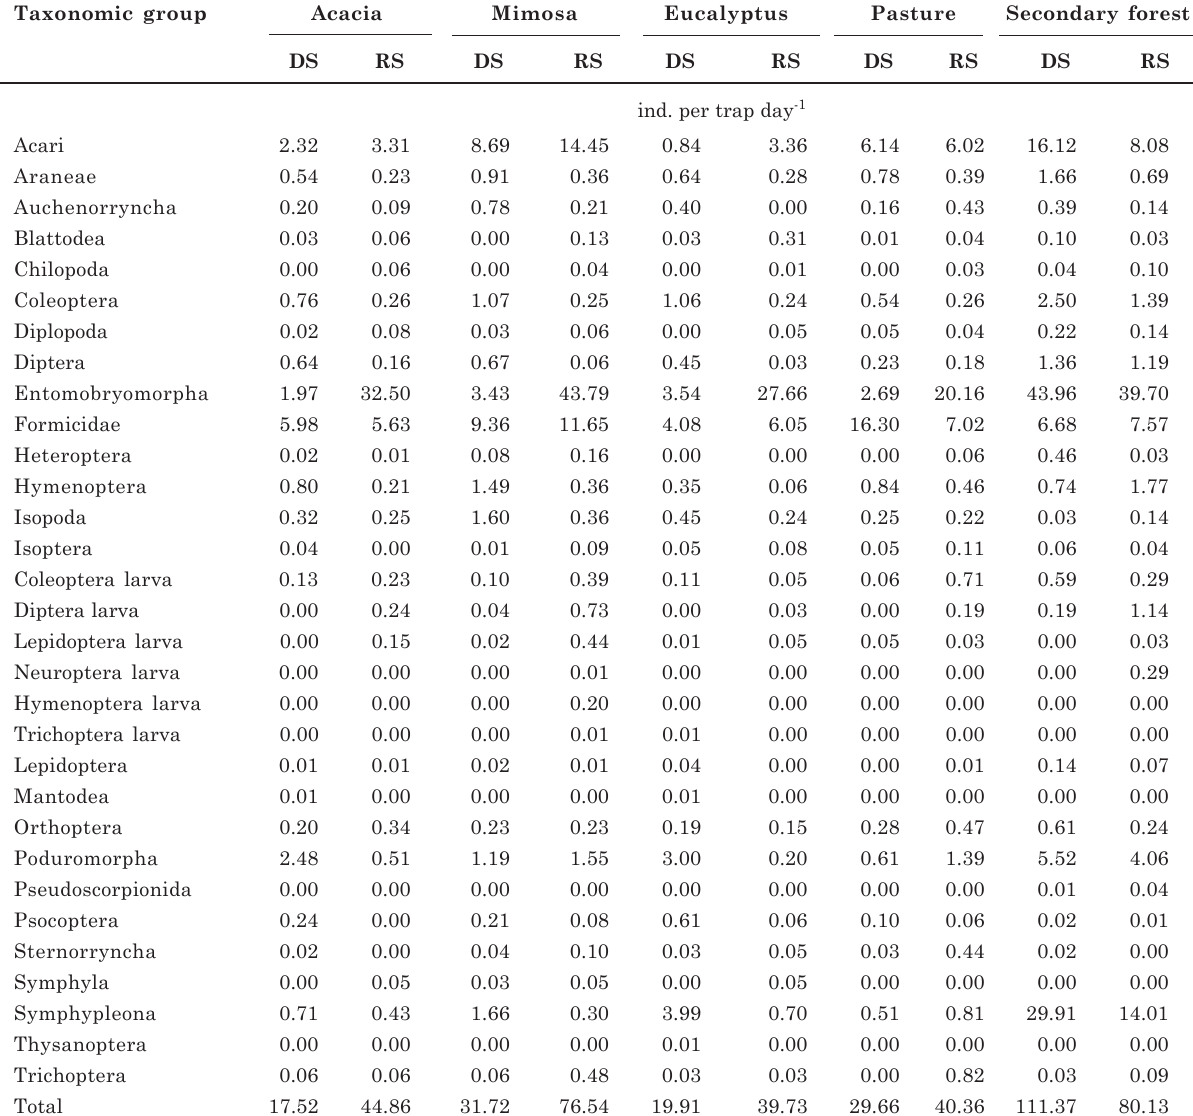
Table 3. Soil fauna abundance of taxonomic groups in the dry (DS) and rainy seasons (RS) in Acacia mangium (acacia), Mimosa artemisiana (mimosa), Eucalyptus grandis × E. urophylla (eucalyptus), pasture, and secondary forest